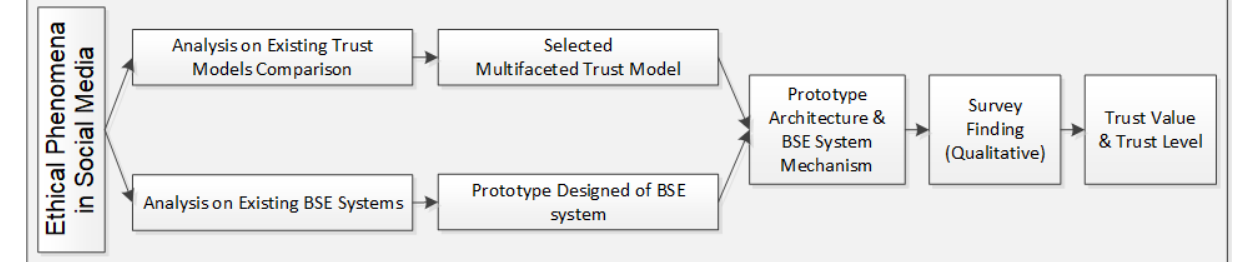
Figure 2. Research flow. BSE: breast self-examination